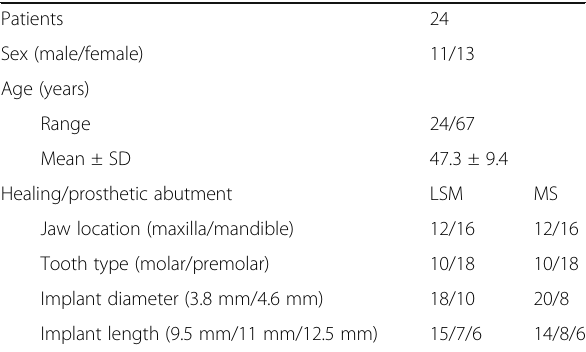
Table 1 Demographics and healing/prosthetic abutment data of study population